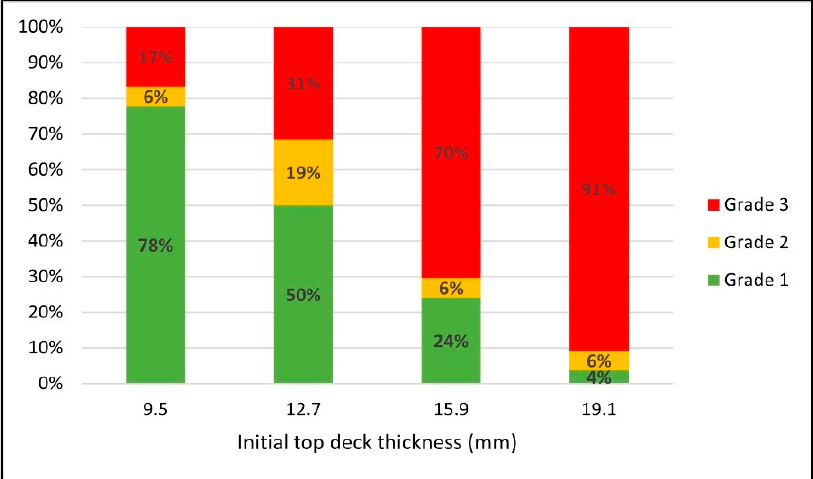
Figure 5. Changes in the proportions of the different grade scenarios in response to the initial top deck thickness for green wood scenarios.